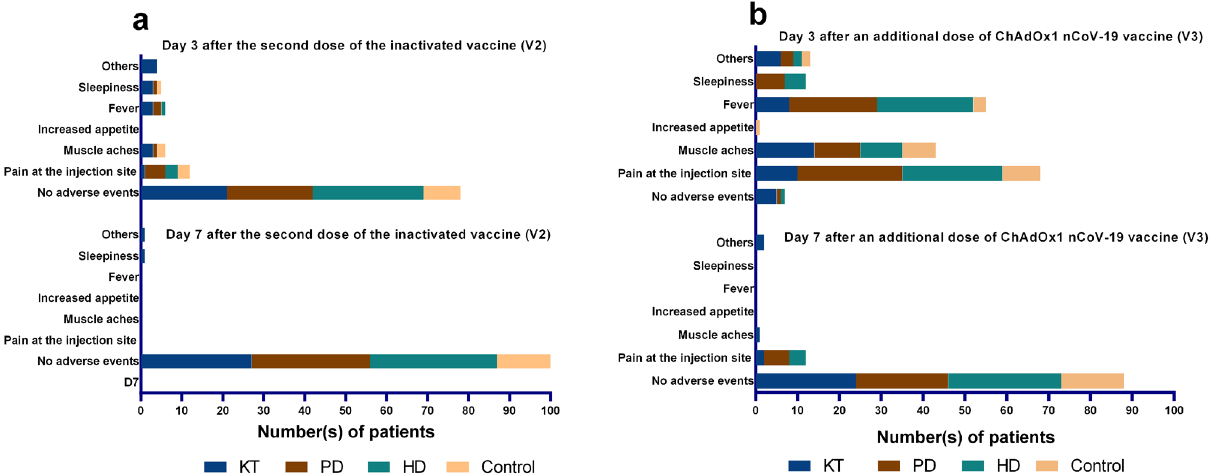
Figure 2. Solicited adverse events on days 3 and 7 after ( a ) the second dose of inactivated SARS-CoV-2 vaccine (V2) and ( b ) the additional dose of ChAdOx1 nCoV-19 vaccine (V3). HD, hemodialysis; KT, kidney transplant; PD, peritoneal dialysis; SARS-CoV-2, severe acute respiratory syndrome